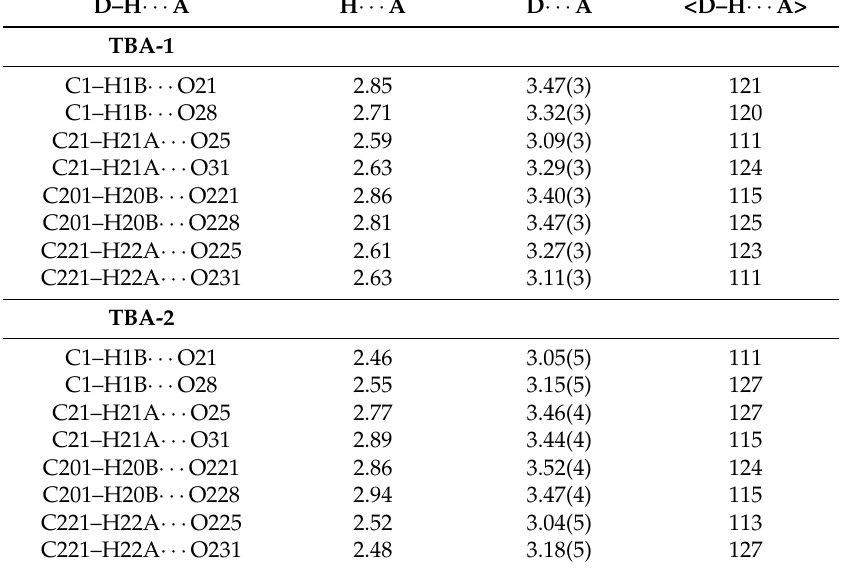
Table 1. Geometrical parameters (Å, ˝ ) for the intramolecular C–H ¨¨¨ O hydrogen bonds involving the methylenic C atoms of the 1-naphthylmethylphosphonate groups and the O POM atoms in compounds TBA-1 and TBA-2